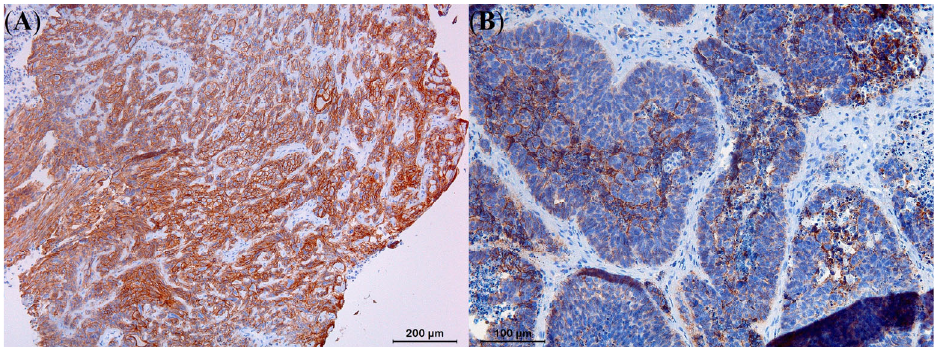
Figure 9. Strong E-cadherin expression with immunoreactivity at the level of the plasma membrane could be noted in all moderately differentiated squamous cell carcinoma cells ( A ), in contrast to moderate to poor expression levels in cells of a solid basal cell carcinoma ( B ).